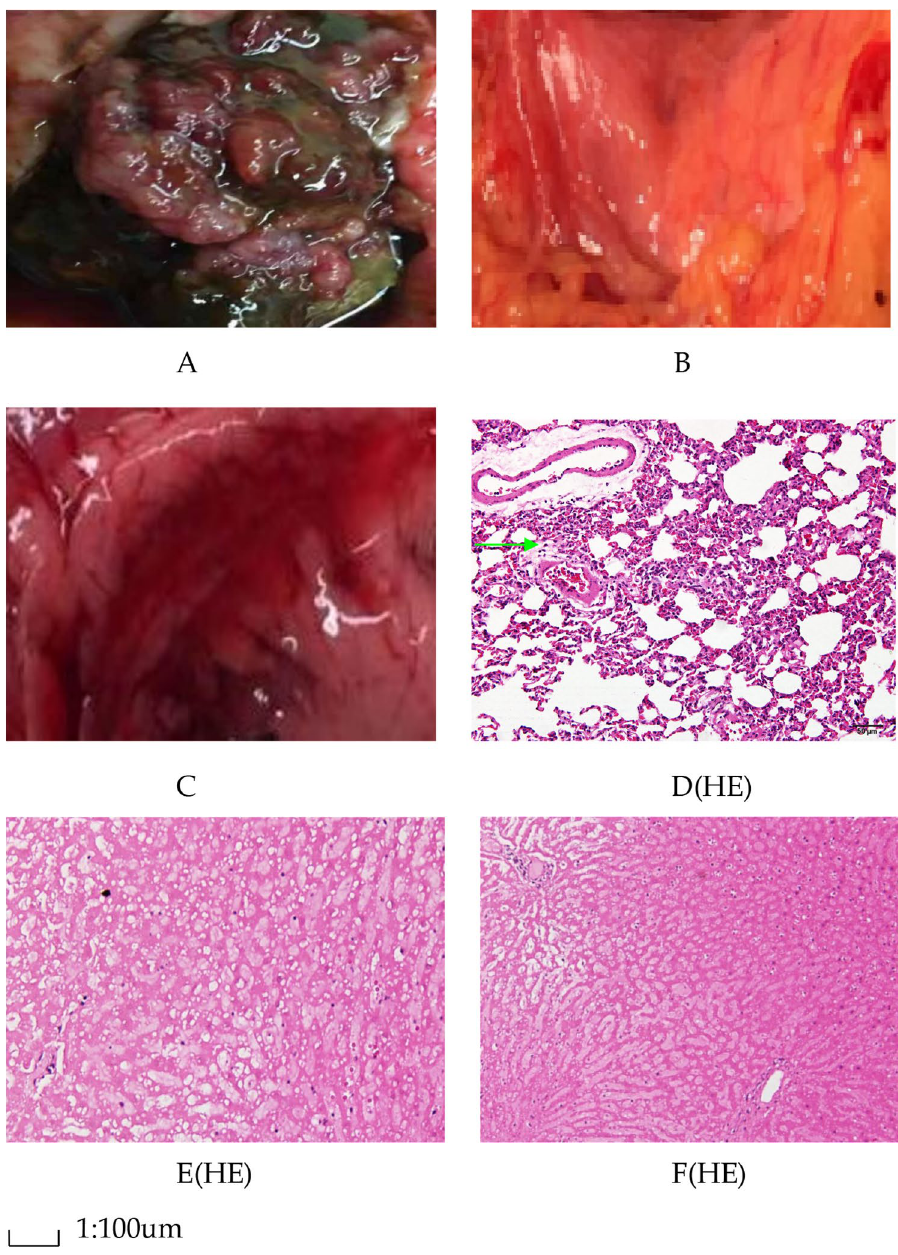
Figure 1. Pathological examination. ( A ) hilar cholangiocarcinoma in experimental group. ( B ) hilar bile duct in control group. ( C ) hilar bile duct in sham operation group. ( D ) tumor cells are indicated by the green arrow in experimental group. HE stain (magnification 100 ×). ( E ) hilar bile duct tissues in control group. HE stain (magnification 100 ×). ( F ) hilar bile duct tissues in sham operation group. HE stain (magnification 100 ×). After 6 weeks, hilar cholangiocarcinomas were detected in hilar bile ducts of 18 rats (90%) in the experimental group, they were cauliflower-like mass in hilar bile ducts. On the contrary only there were mild inflammation and edema in hilar bile ducts in control group and sham operation group. The tumor cells were multinucleated and the mitochondrias were swollen, the cells in control group and sham operation group were mild